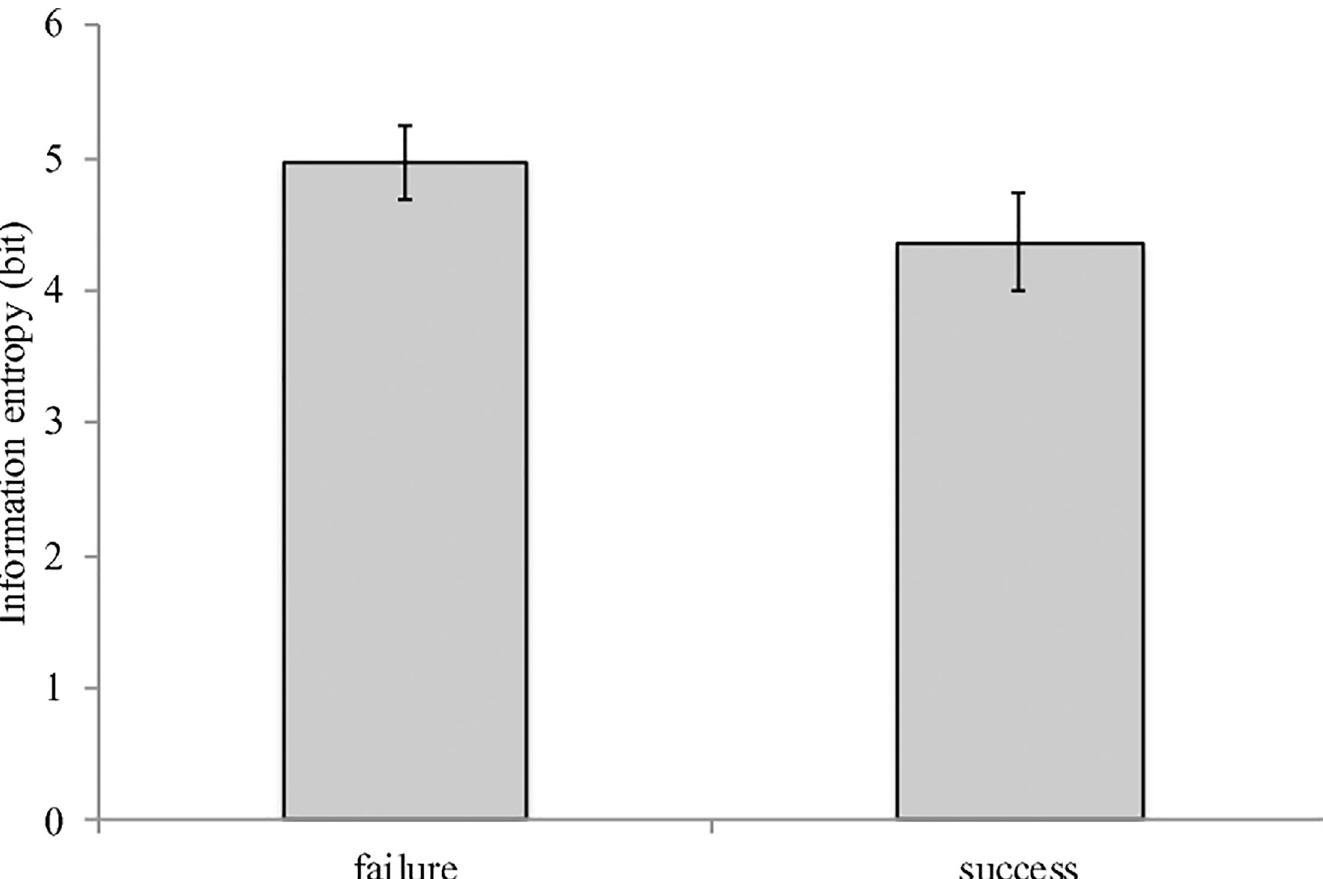
Fig 7. The average information entropy of the relative phase for the success trials and the failure trials. The error bars indicate the standard deviation over the 16 participants.